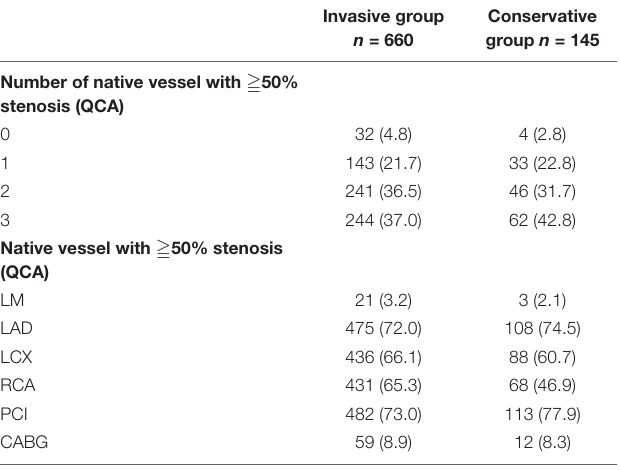
TABLE 3 | Angiographic characteristics and revascularization procedures.